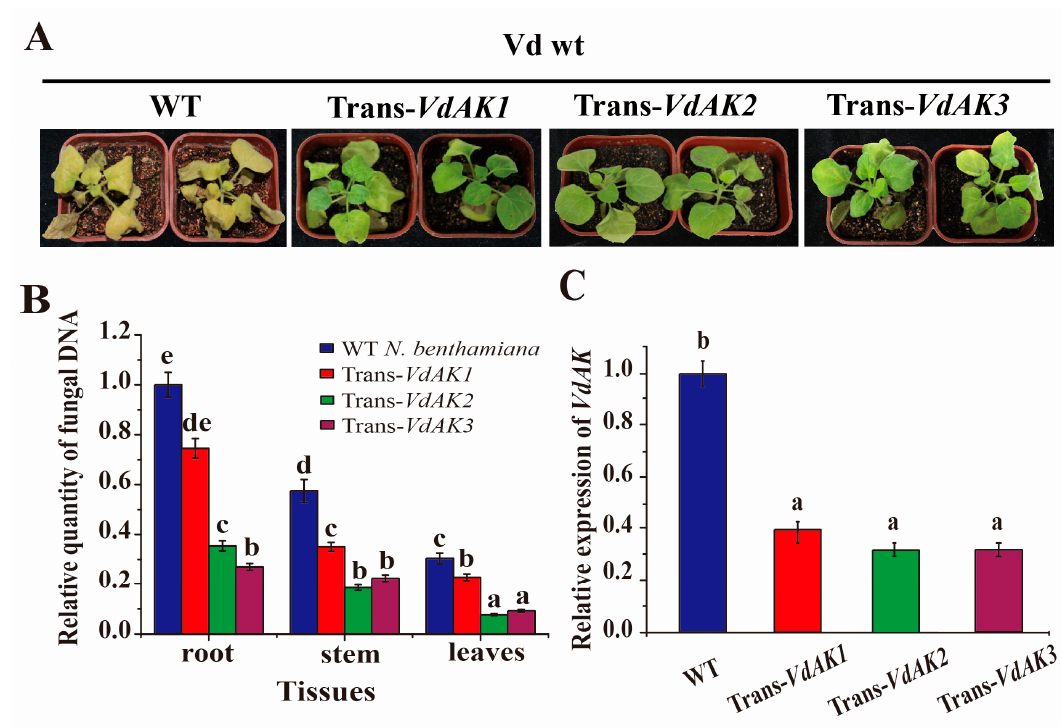
Figure 4. Expression of dsRNA of VdAK improved Vd resistance in N. benthamiana compared to wild-type plants (WT). WT and trans- VdAK plants were inoculated with wild-type Vd (Vd wt). ( A ) Symptoms on transgenic and wild-type plants at 12 days after roots were dipped in 10 6 spores / mL of the respective strains. ( B ) Relative amounts of fungal DNA as determined by RT-qPCR. ( C ) Transcript levels of VdAK in stems of transgenic and WT plants. Means ( ± SE) from three independent experiments that di ff ered significantly among treatments in Duncan’s test ( p < 0.05) are indicated by di ff erent letters.